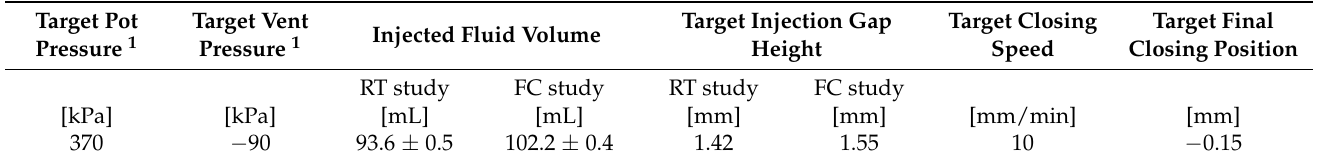
Table 1. Process conditions of experiments for the race-tracking (RT) and flow control (FC) studies. Target